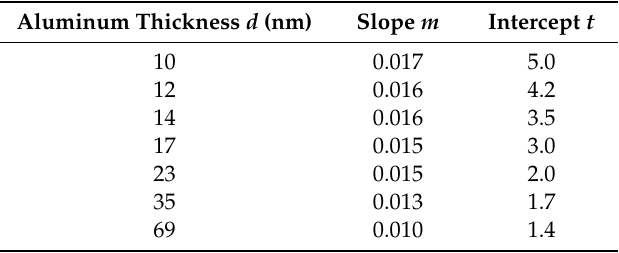
Table 1. Slope m and y -axis intercept t for Figure 11a, deduced from Equations (6) and